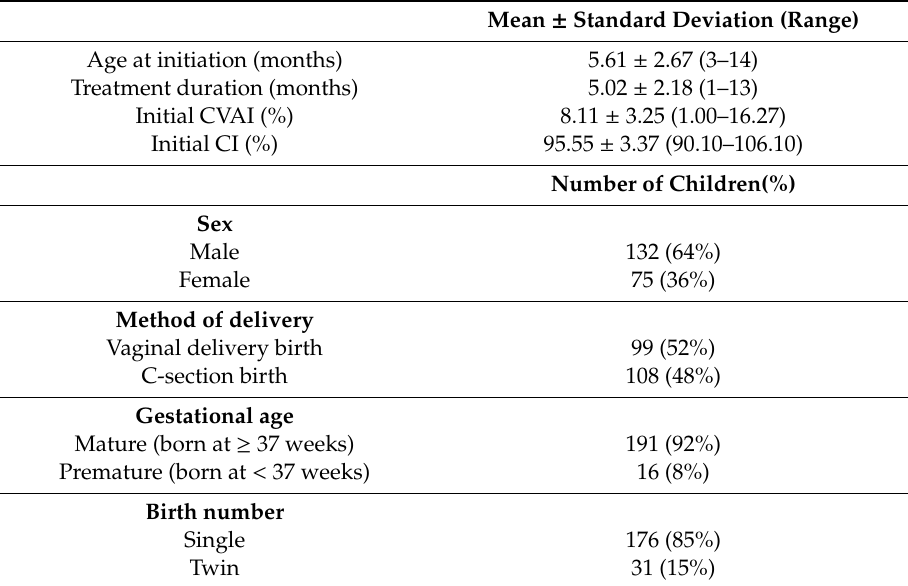
Table 2. Demographics and clinical features of patients.